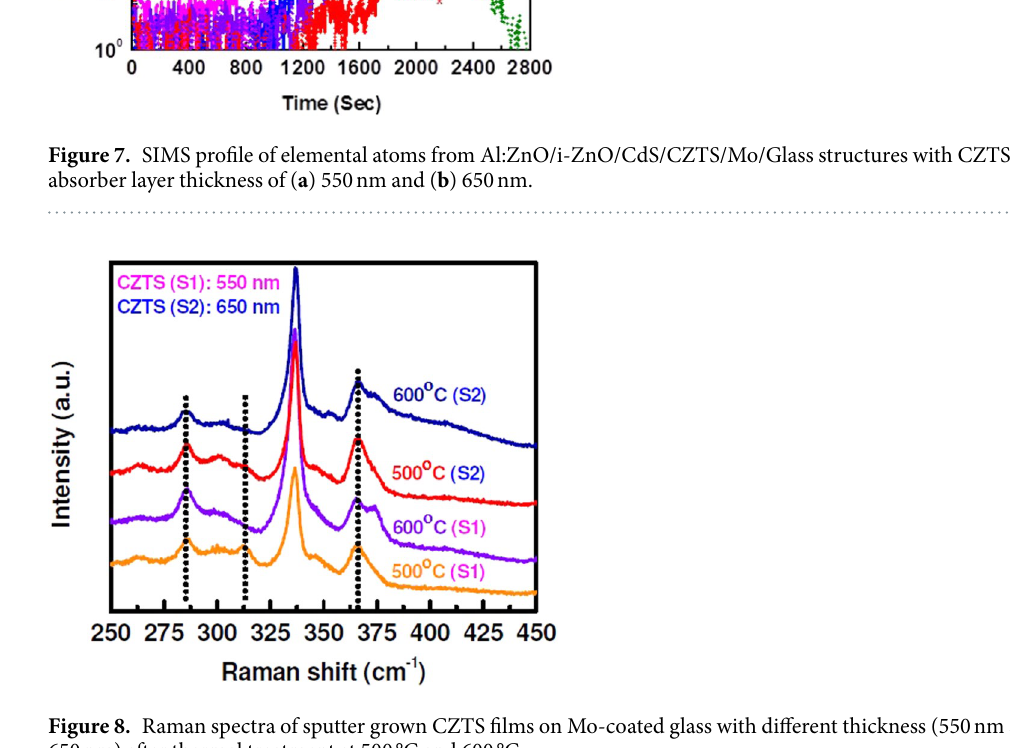
Figure 8. Raman spectra of sputter grown CZTS films on Mo-coated glass with different thickness (550 nm and 650 nm) after thermal treatment at 500 °C and 600